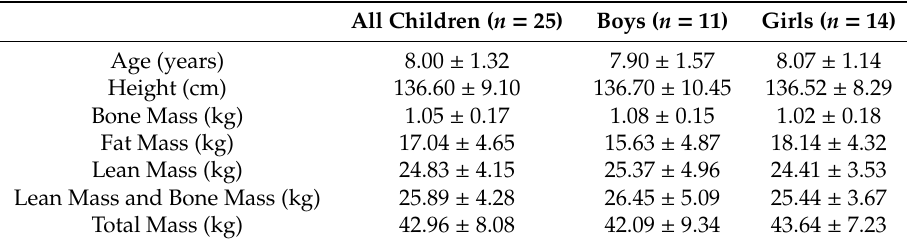
Table 1. Characteristics of the children who have been included in the